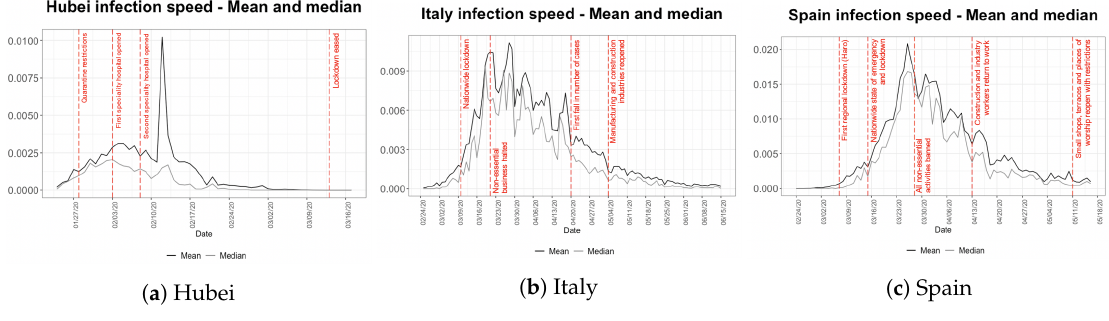
Figure 4. Time series plots for mean and median infection